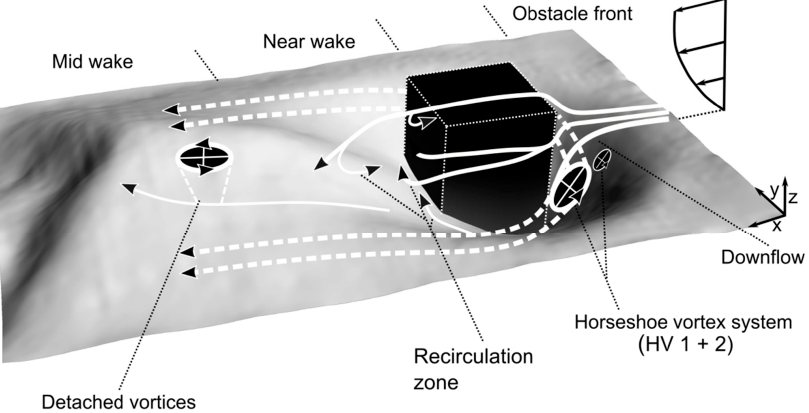
Figure 2. Simplified flow field in the vicinity of a submerged cuboid obstacle. Adapted from Schlömer et al. [29].